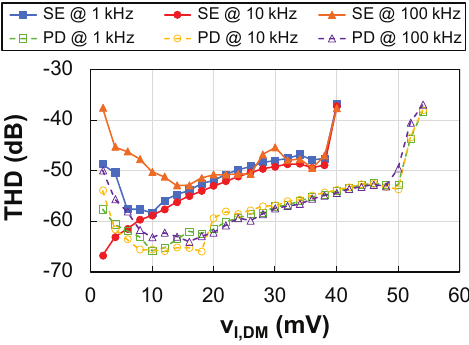
Figure 11. Measured THD as a function of v I , DM for different values of the